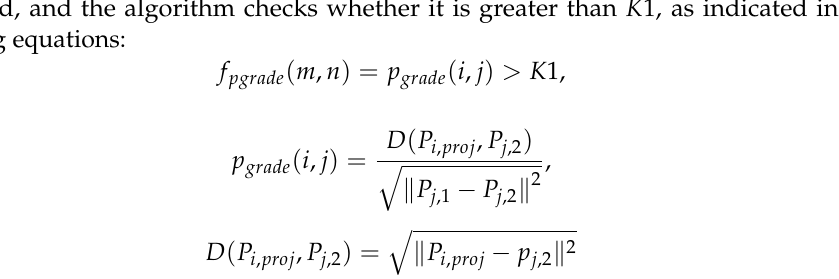
Figure 5. Process of detecting abnormal vertebral slippage in X-ray images by using P-grade. Each P-grade corresponding to the L 1- L 2, L 2- L 3, L 3- L 4, L 4- L 5, and L 5- S 1 levels